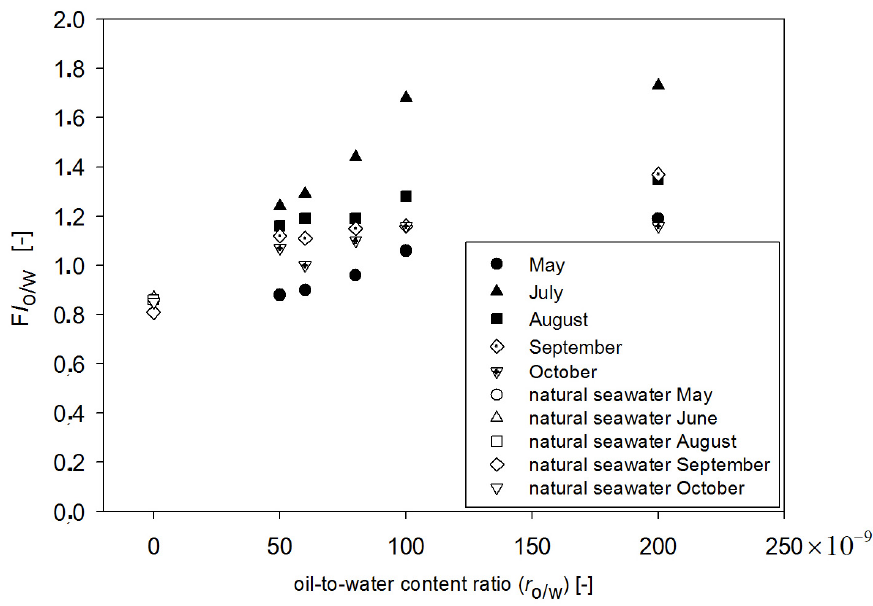
Figure 8. Fluorescence index for both oil-free seawater and seawater polluted with oil as a function of the oil-to-water ratio for May, July, August, September, and October.